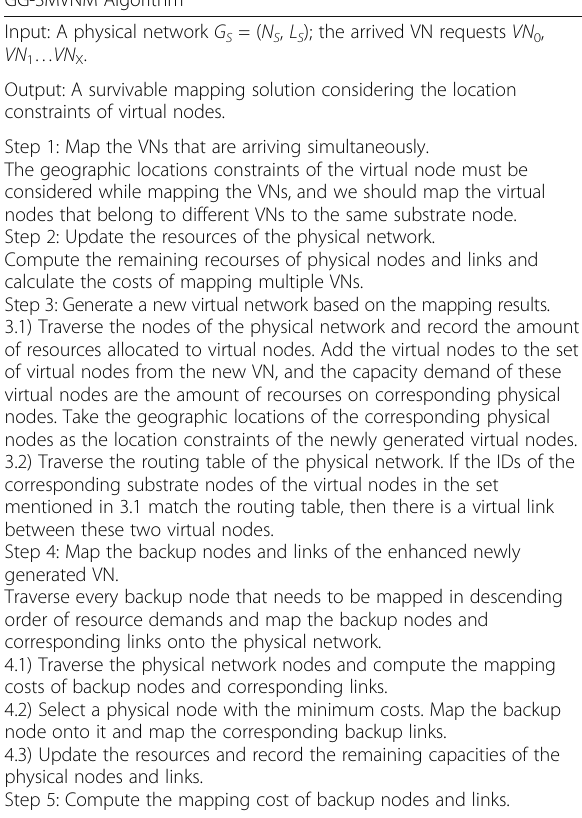
Table 1 Pseudo code of the GG-SMVNM algorithm GG-SMVNM Algorithm